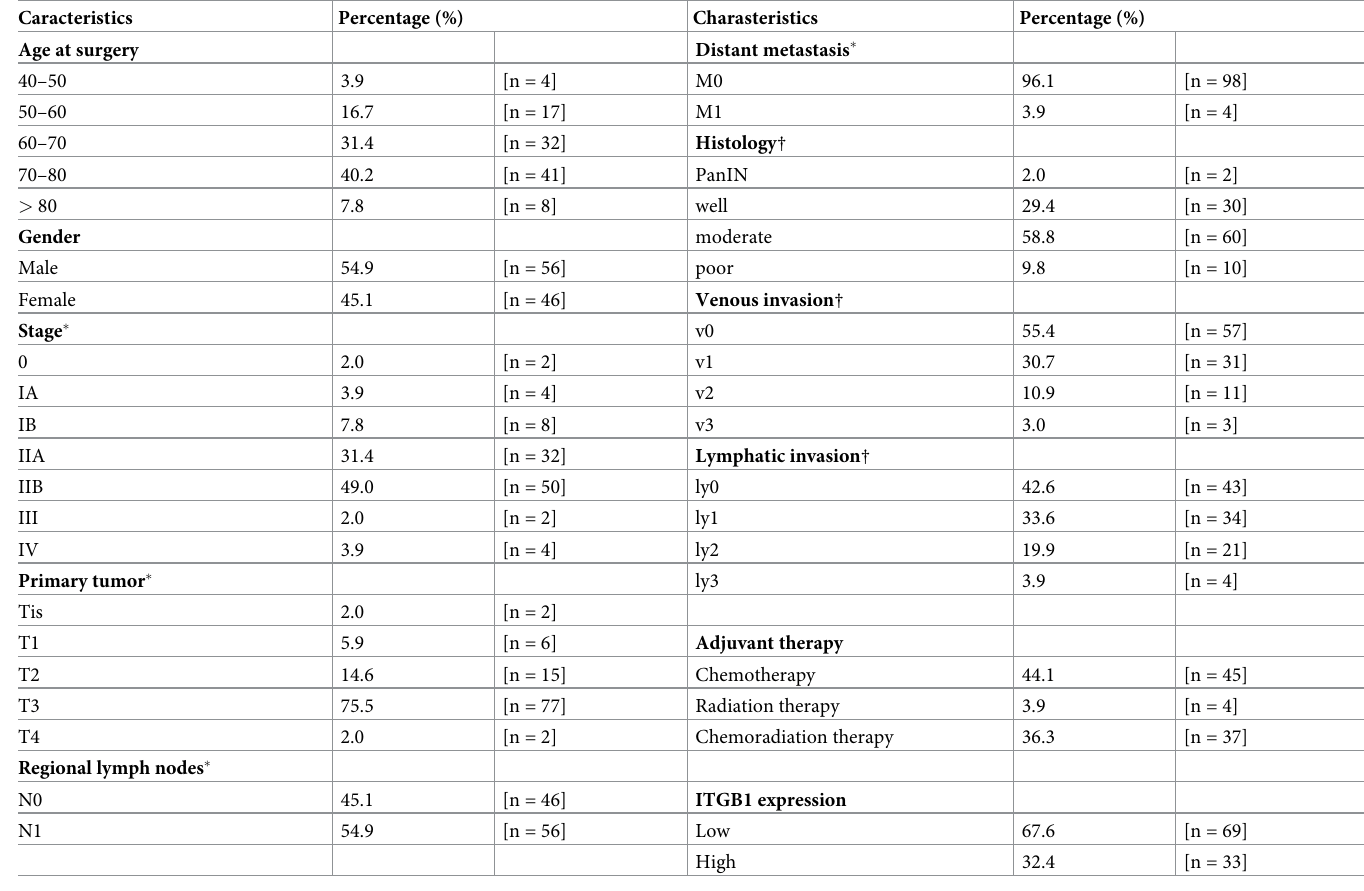
Table 1. Summary of characteristics of 102 patients with pancreatic cancer.